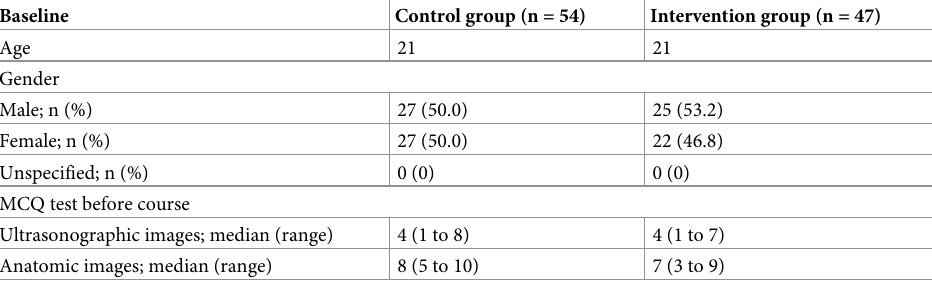
Table 1. Demographic of 101